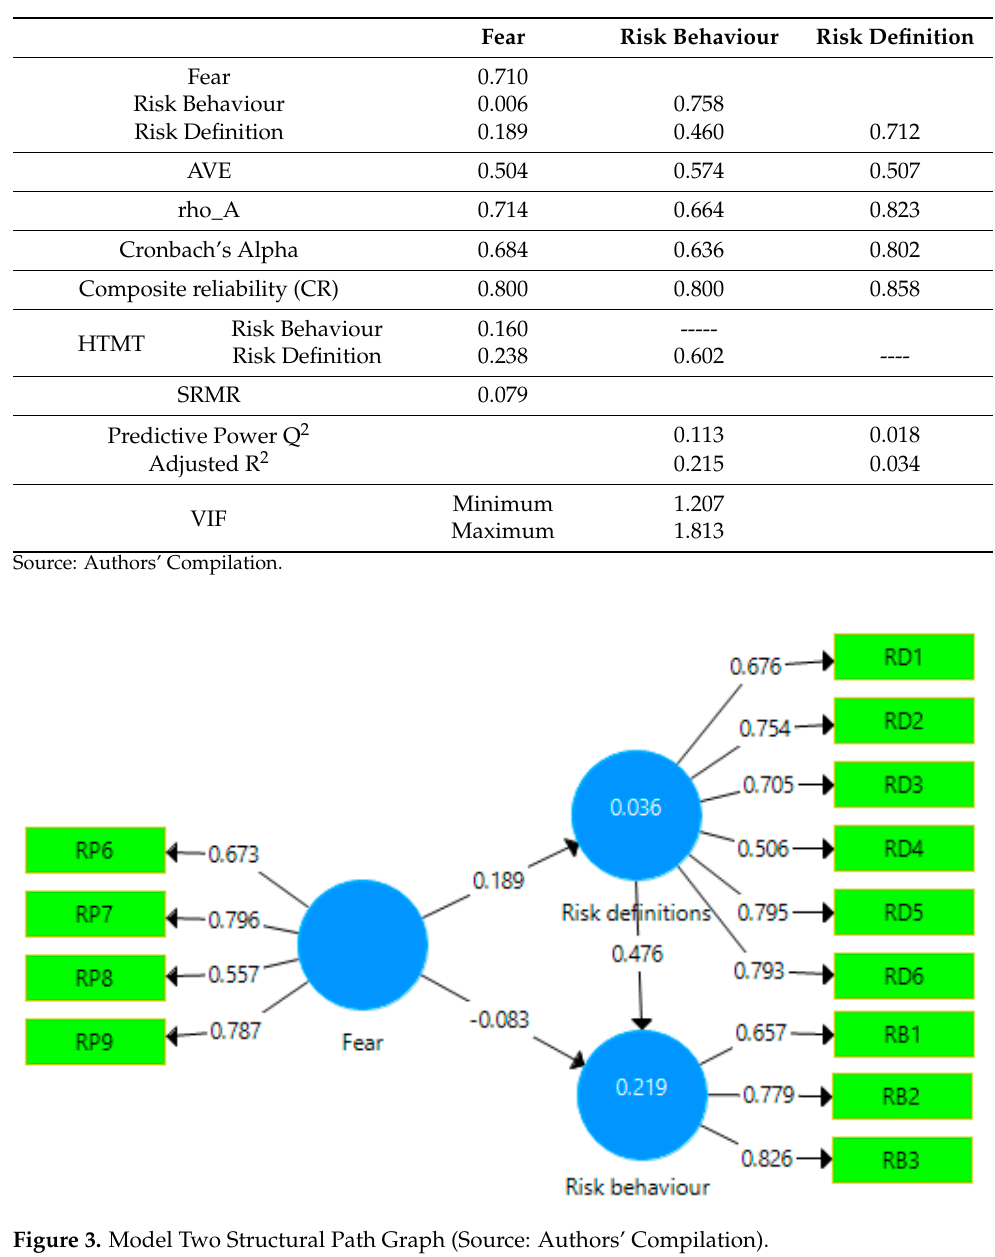
Table 5. Evaluation of Reflective Measurement Models and Structural Models for Model Two.